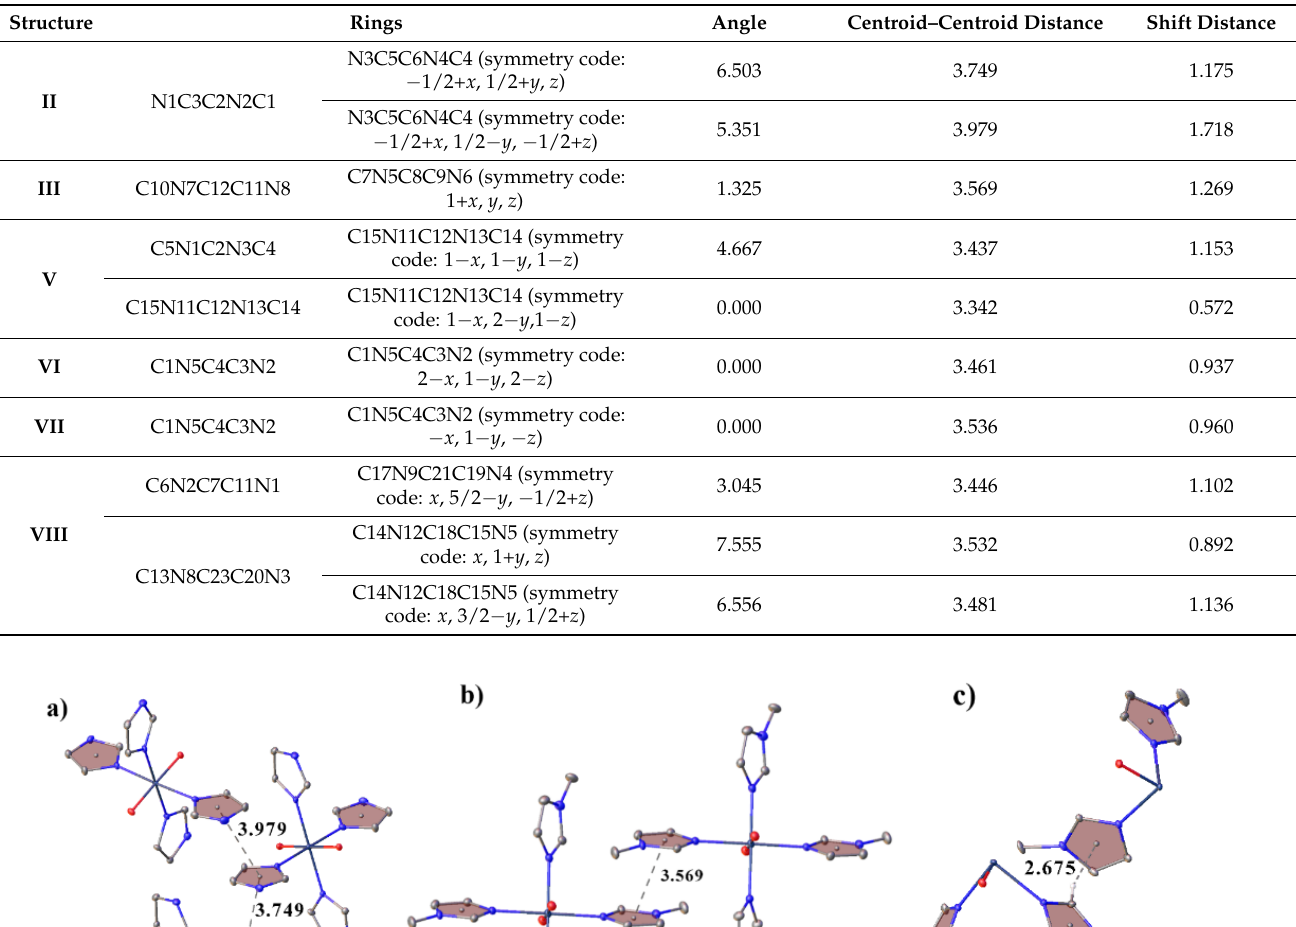
Table 1. Parameters of π –stacking interactions.